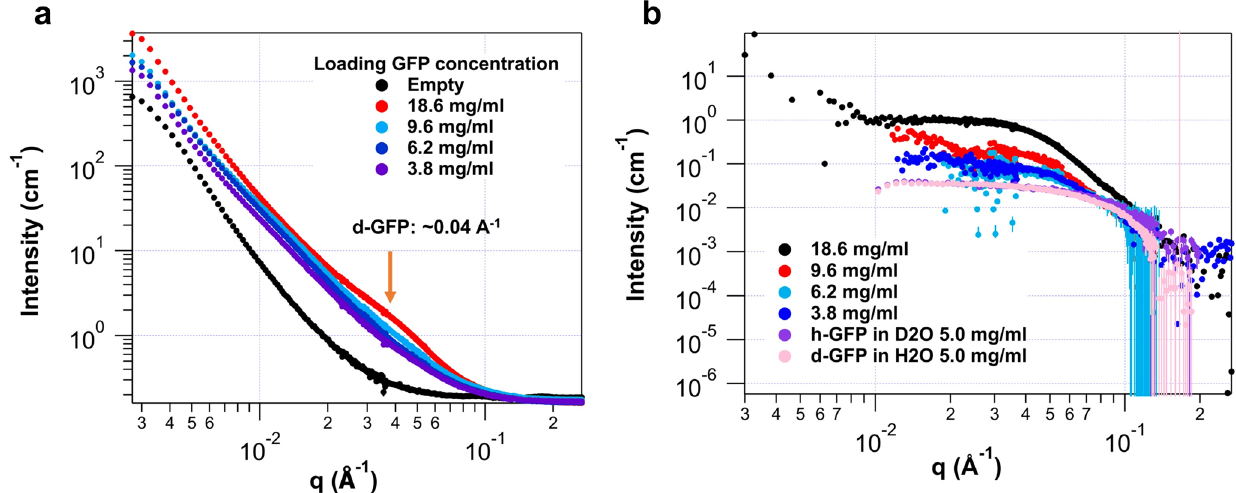
Fig. 2 | SANS pro fi les of d-GFP@MOF-919 (C1 – C4). a SANS Pro fi les of MOF-919 with d-GFP as a function of protein concentration at the contrast matching point 50% D 2 O. A hump developed at ~0.04Å − 1 (orange arrow) with the decrease of loading protein concentration, which is attributed to the presence of d-GFP in the